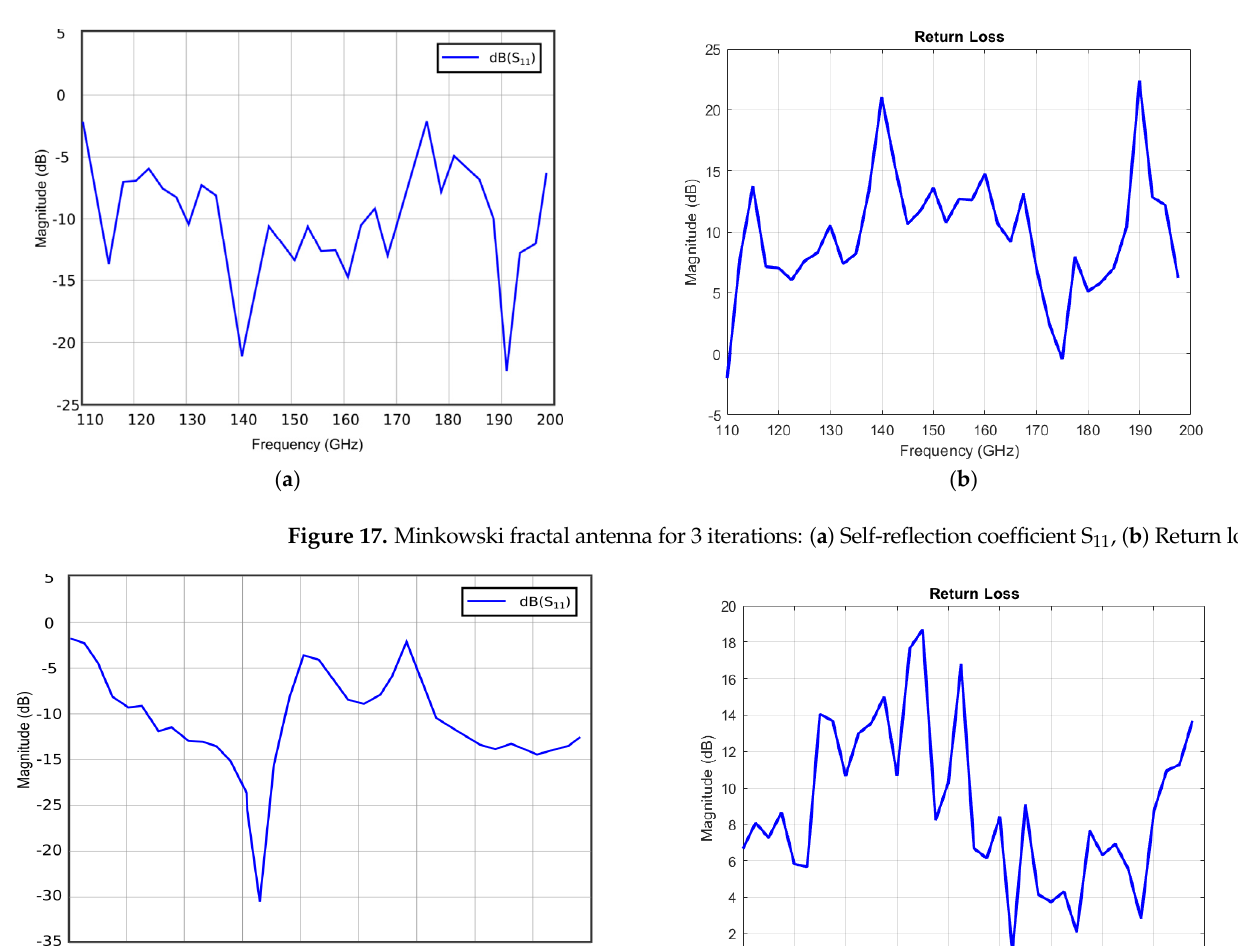
Figure 16. Minkowski fractal antenna for 2 iterations: ( a ) Self-reflection coefficient S 11 , ( b ) Return loss.